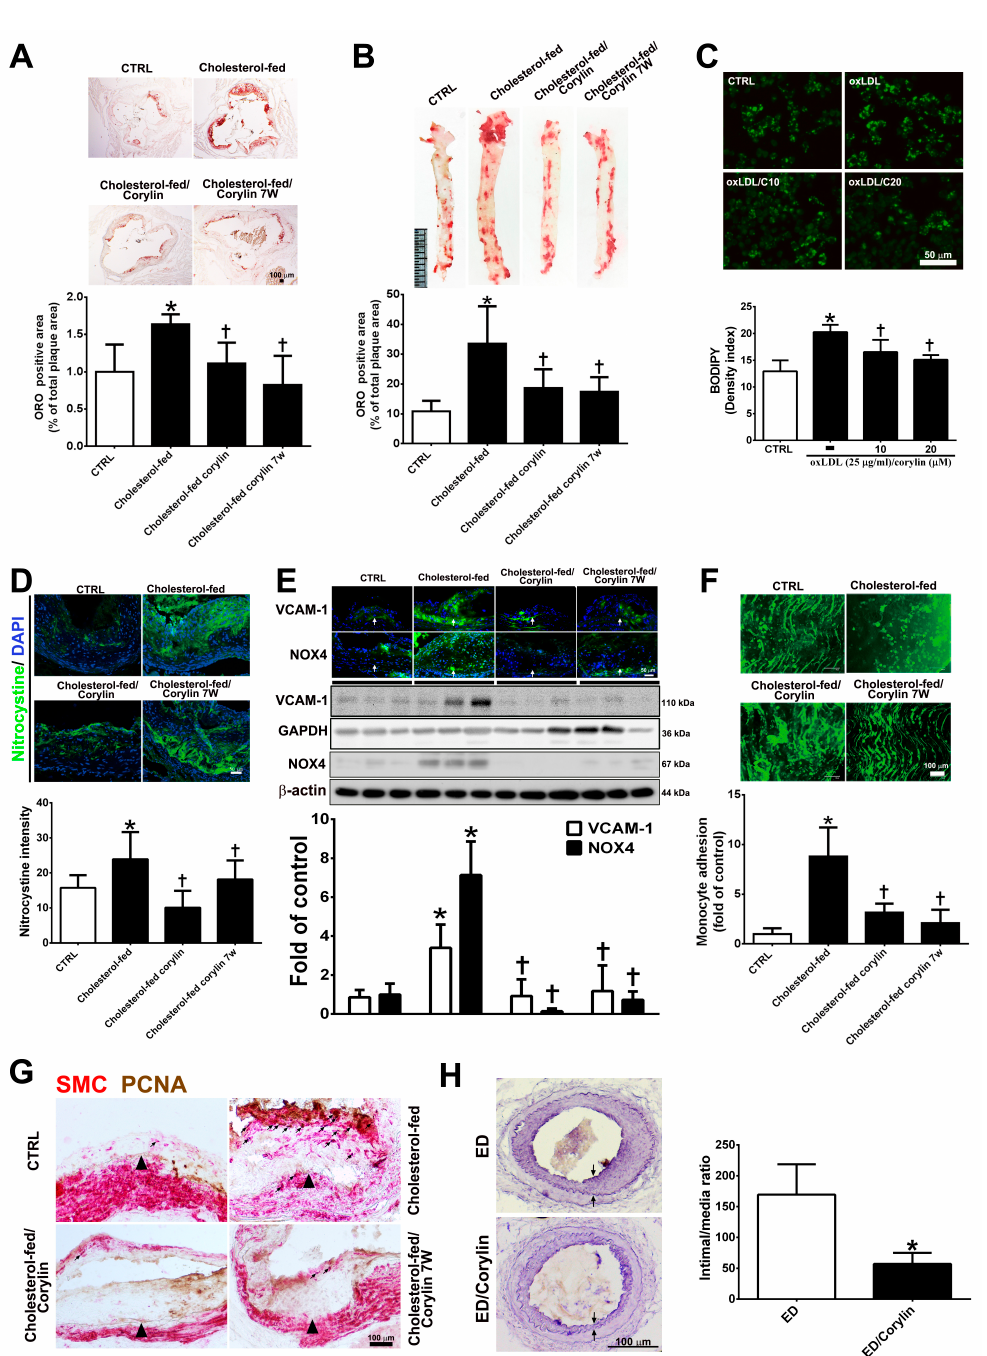
Figure 8. Corylin reduces oxidative stress, VCAM-1 and NOX4 expression, monocyte adhesion, VSMC proliferation and atherosclerotic plaques in high cholesterol diet-treated aortae. ( A , B ) Oil Red O staining was performed on aortic sinus and thoracic aortic tissues. Representative photomicrographs are shown with quantifications of the ORO-positive area represented as a percentage of the total atherosclerotic plaque area. ( C ) Lipid droplets were stained using Bodipy. Representative images and quantification of the intensity of lipid staining within the oxLDL-treated RAW264.7 cells. ( D ) Representative images and quantification of the intensity of nitrotyrosine staining within the aortic sinus. Nuclei were labeled with DAPI (blue). ( E ) The expression level of VCAM-1 and NOX-4 in atherosclerotic plaques is shown according to immunohistochemical staining and Western blot analysis of the di ff erent groups.